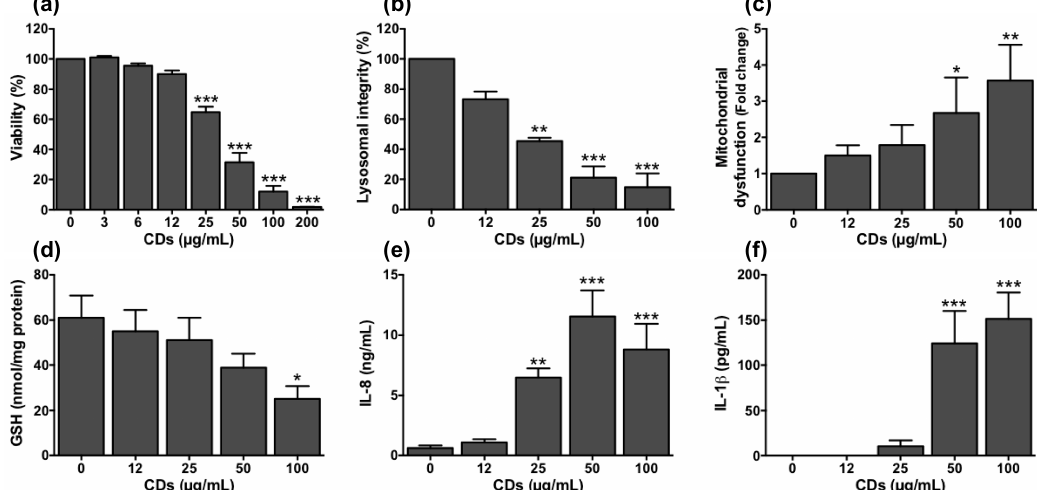
Figure 6. Cellular mechanisms involved in the toxicity of CDs towards cultured macrophages. Cells were exposed or not with increasing concentrations of CDs for 24 h ( a , b , e and f ) or 4 h ( c , d ). Cell viability ( a , MTT assay), lysosomal integrity ( b , neutral red assay), mitochondrial dysfunction ( c , mitochondrial membrane perturbation assay), oxidative stress ( d , reduced glutathione), inflammatory response ( e , IL-8 secretion) and NLRP3 inflammasome activation ( f , IL-1 β secretion) were measured at 4 h ( c , d ) or 24 h ( a , b , e and f ). Data are means ± SEM of n = 3–6 experiments. They are expressed in percentage of controls ( a , b ), fold change ( c ), or as absolute values ( d – f ). Statistical differences when compared to controls were determined by ANOVA followed by the Dunnett’s test. * p < 0.05; ** p < 0.01; *** p < 0.001.